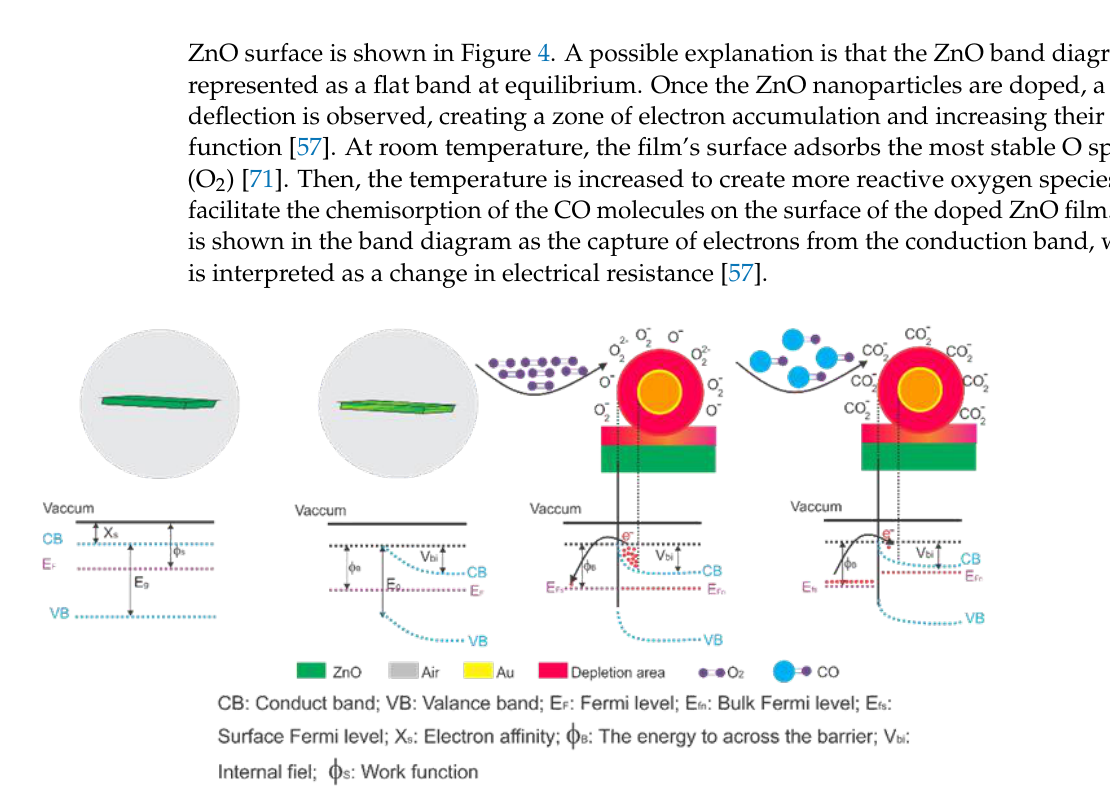
Figure 4. Gas sensing mechanism and energy band of zinc oxide doped before and after CO exposure nanostructures. Modified from reference [57].